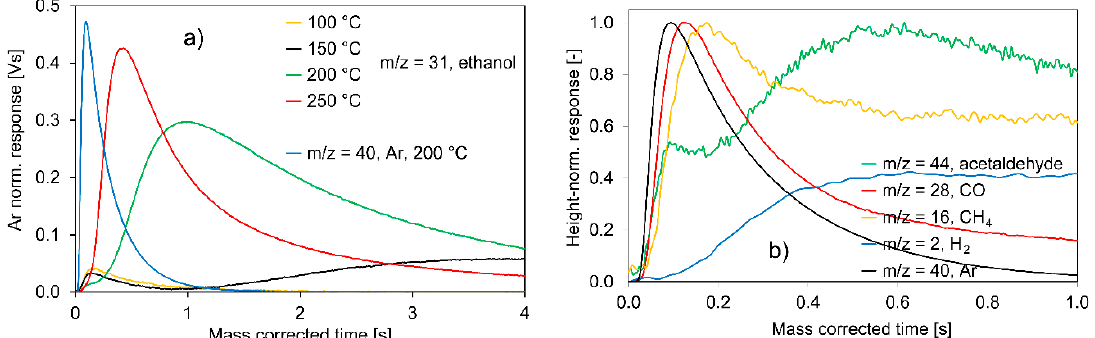
Figure 10. ( a ) Ar-normalized transient responses to pulses of 34.6 vol % ethanol in Ar at temperatures between 100 ◦ C and 250 ◦ C on the H 2 pre-reduced Cu / C catalyst (20 mg) at an m / z-value of 31 for ethanol; response pulse of Ar (m / z-value of 40) at 200 ◦ C for comparison. ( b ) Height-normalized transient responses to pulses of 34.6 vol % ethanol in Ar at m / z-values of 2 for H 2 , 16 for CH 4 , 28 for CO, 44 for acetaldehyde and 40 for Ar on the H 2 pre-reduced Cu / C catalyst (20 mg), T = 200 ◦ C.